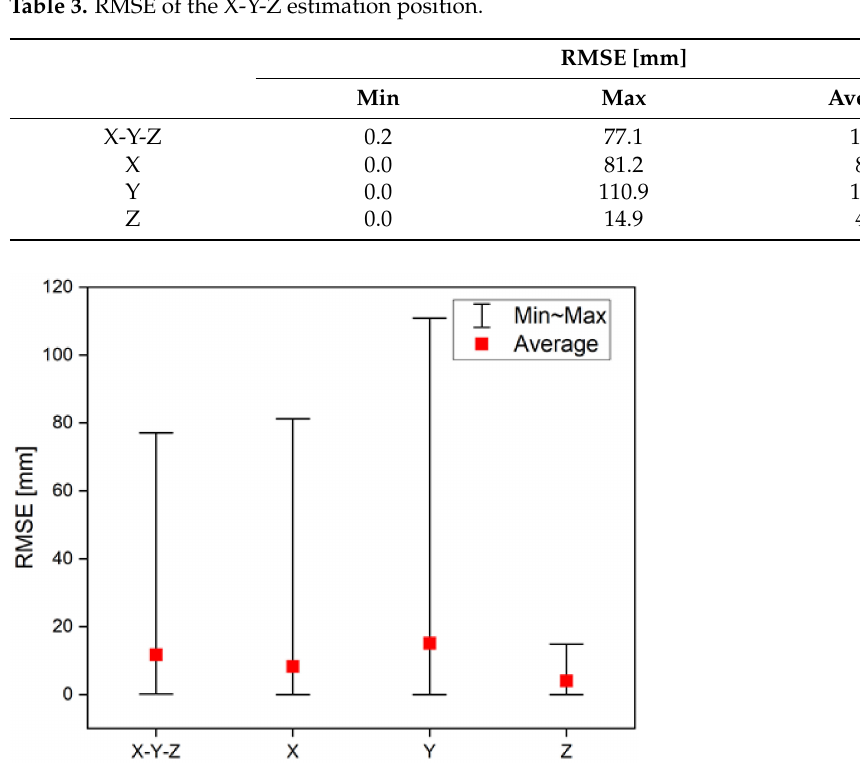
Figure 8. RMSE graph of the X-Y-Z estimation